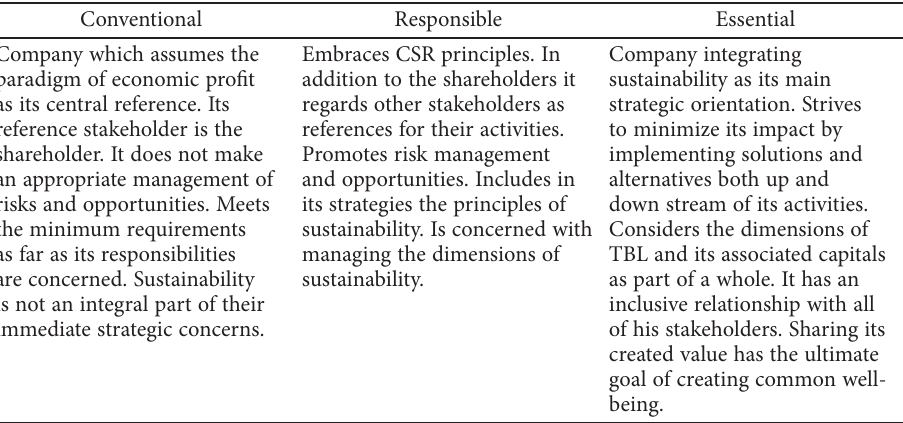
Table 2. Differentiation between types of sustainable